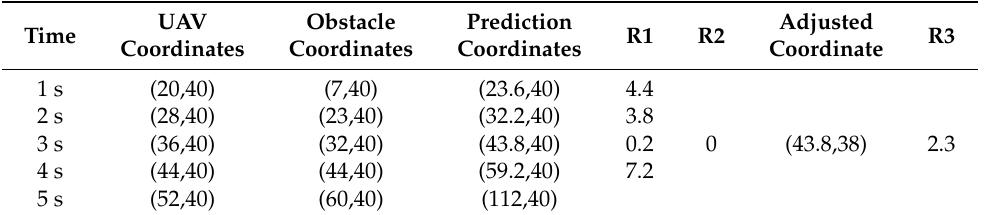
Table 9. Coordinate information of the local path adjustment in Figure 20b.